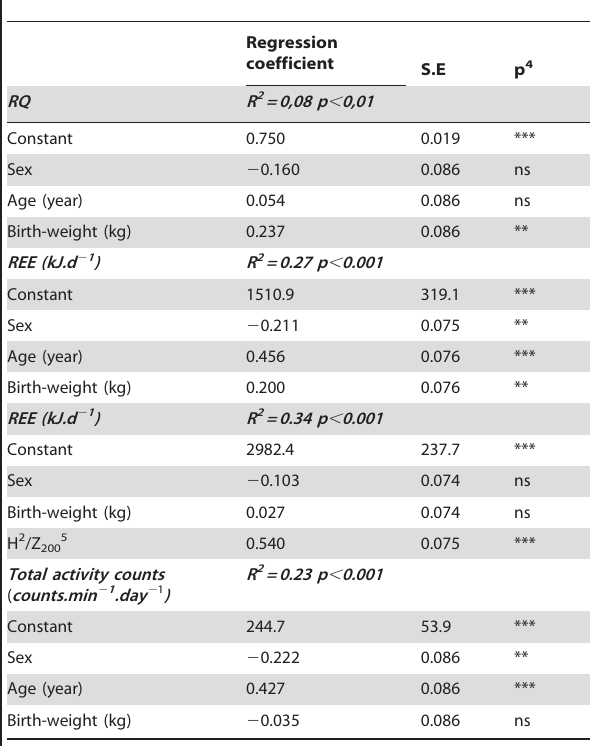
Table 4. Multiple regression models between RQ 1 , REE 2 , physical activity (dependant variables) and birth-weight, age, gender 3 and H 2 /Z 200 (independent